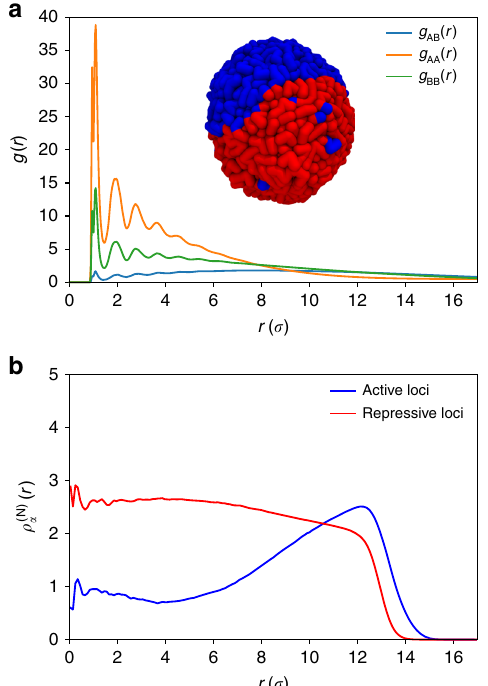
Fig. 2 Micro-phase separation between active and repressive loci. a Radial distribution functions, g ( r ), as a function of r (in the unit of σ ) between active – active loci ( g AA ( r )), repressive – repressive loci ( g BB ( r )) and active – repressive loci ( g AB ( r )). The inset shows the typical conformation of the compact chromosome. Blue and red segments correspond to active and repressive loci, respectively. The structure vividly reveals micro-phase separation between active and repressive loci. b The normalized radial density, ρ ð N Þ α ð r Þ ¼ h N α ð r Þi V = ð 4 π r 2 Δ rN α Þ , where N α ( r ) is the number of loci of given type α found in the spherical shell between r and r + Δ r , N α is the total number of loci of that type. The bracket h(cid:3)i is the ensemble average, V is the volume of the globule, given by ð 4 = 3 Þ π r 3 , where r max = 17 σ ; ρ ð N Þ α ð r Þ max shows that the active loci are predominantly localized on the periphery of the condensed chromosome. The repressive loci are more uniformly